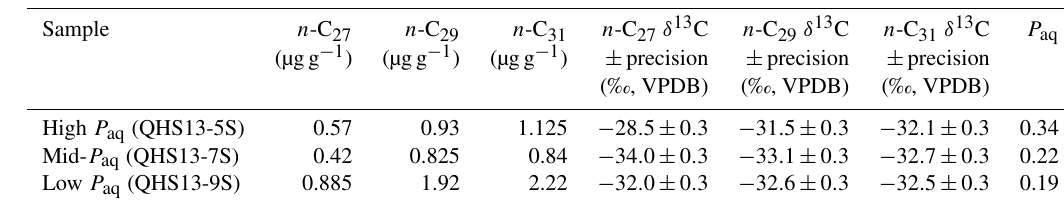
Table 1. Lake surface sediment samples used in case study 1, with measured chain-specific n -alkane concentrations and δ 13 C values; these data were originally published by Liu et al. (2015).